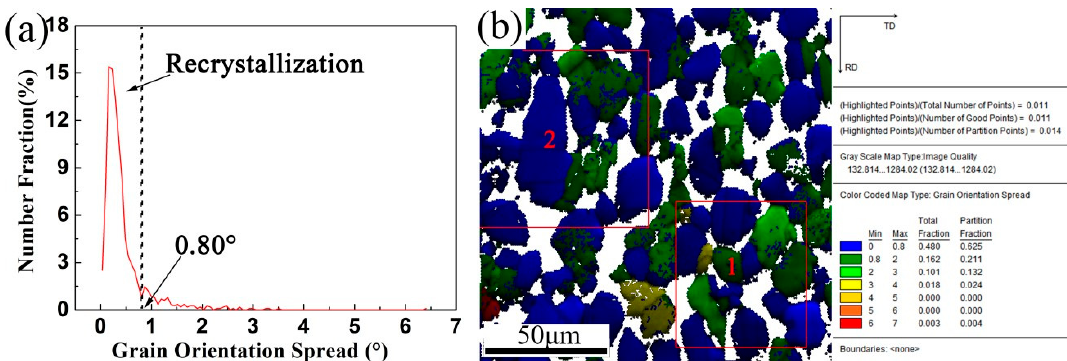
Figure 7. GOS distributions of the γ phase in the Ti-43Al-9V-0.2Y alloy sheet: ( a ) The curves of GOS distributions; ( b ) Maps of GOS with image quality.